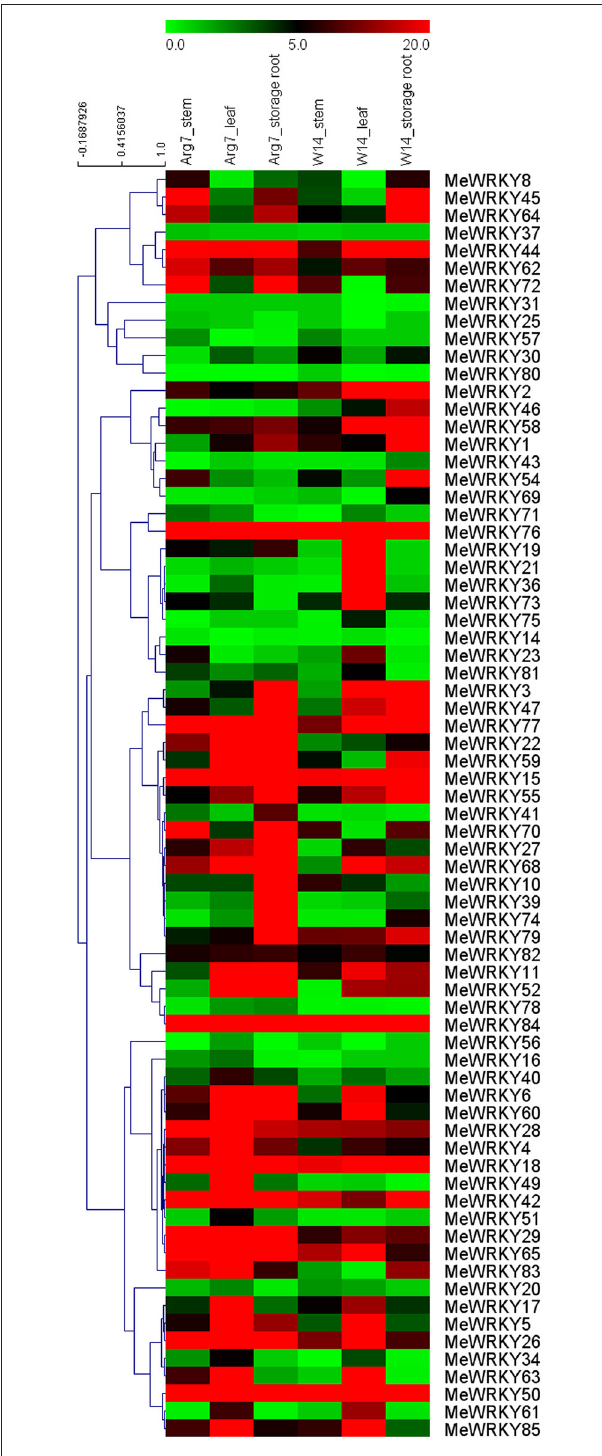
FIGURE 4 | Expression profiles of MeWRKY genes in different tissues of two cassava accessions. FPKM value was used to create the heat map with clustering. The scale represents the relative signal intensity of FPKM values.